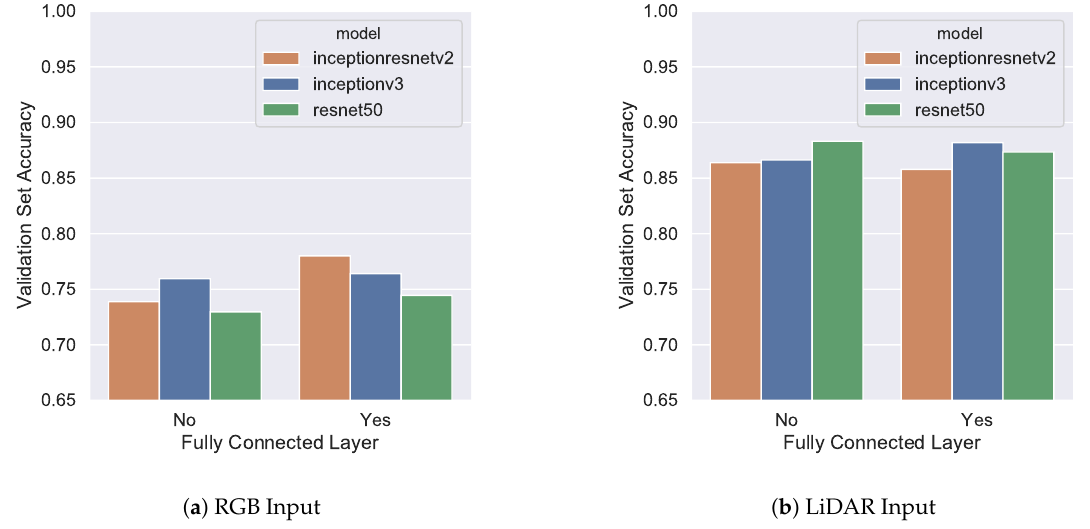
Figure 10. Comparison between CNN validation set accuracy. Colors indicate the base model used while the horizontal axis specifies whether a fully connected layer is part of the architecture. ( a ) RGB (satellite) image input and ( b ) LiDAR image